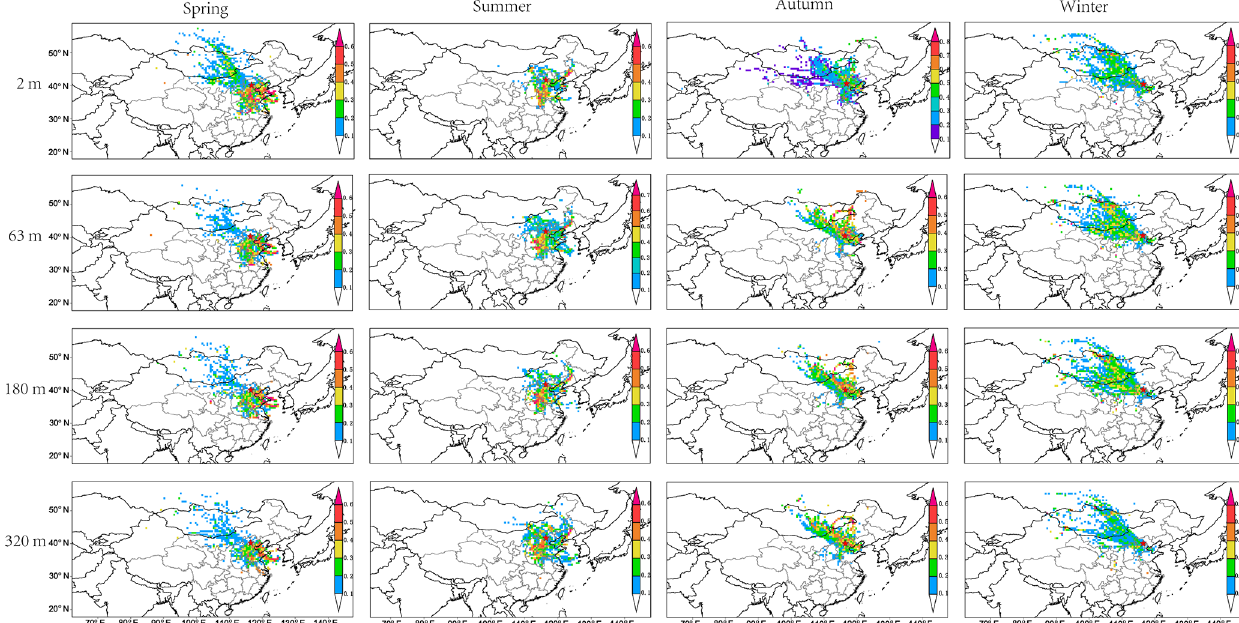
Figure 6. Weighted potential source contribution analysis (WPSCF) of atmospheric NH 3 in Beijing from 16 March 2016 to 16 March